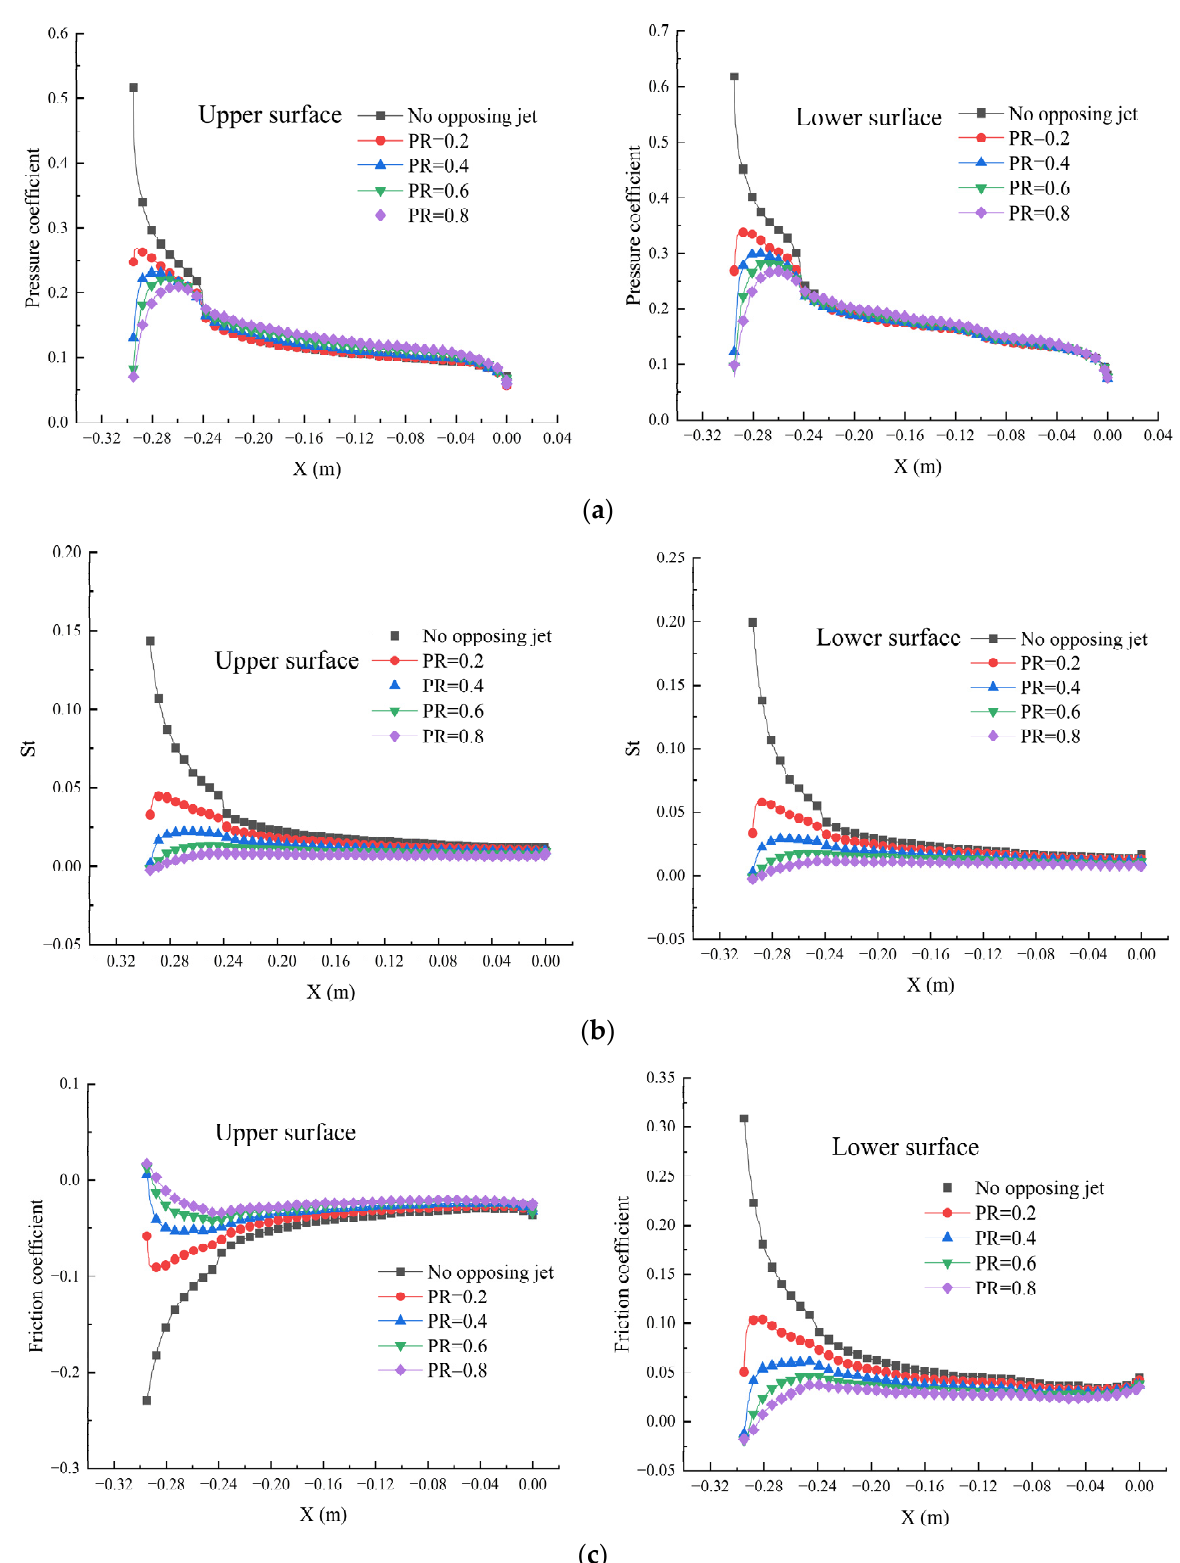
Figure 15. Contour of density nephogram and streamline of truncated cone: ( a ) No opposing jet; ( b ) PR = 0.2; ( c ) PR = 0.4; ( d ) PR = 0.6; ( e ) PR = 0.8.